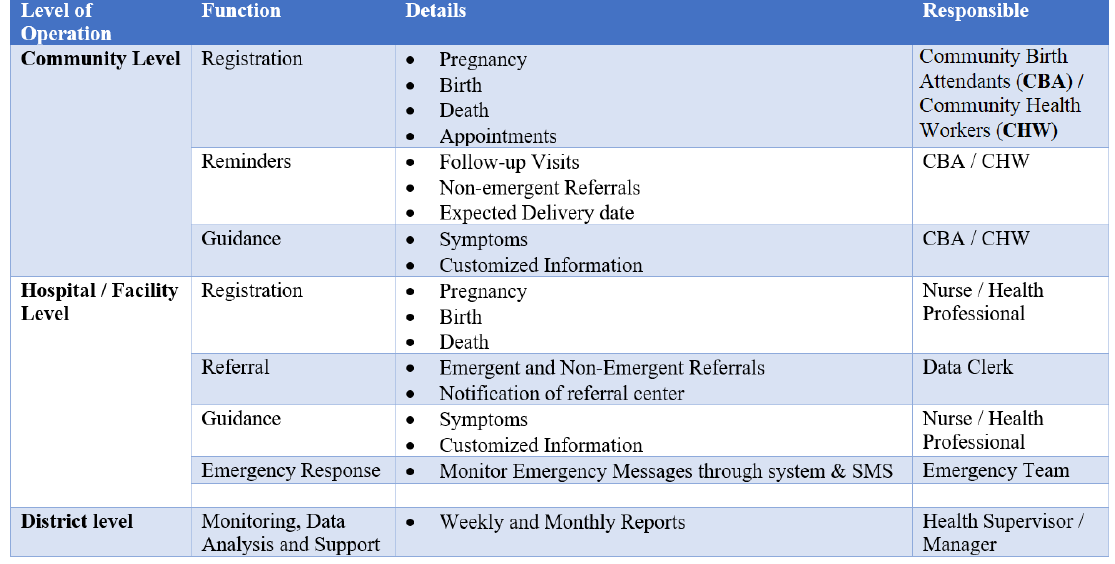
Figure 8. System features of the pregnancy care